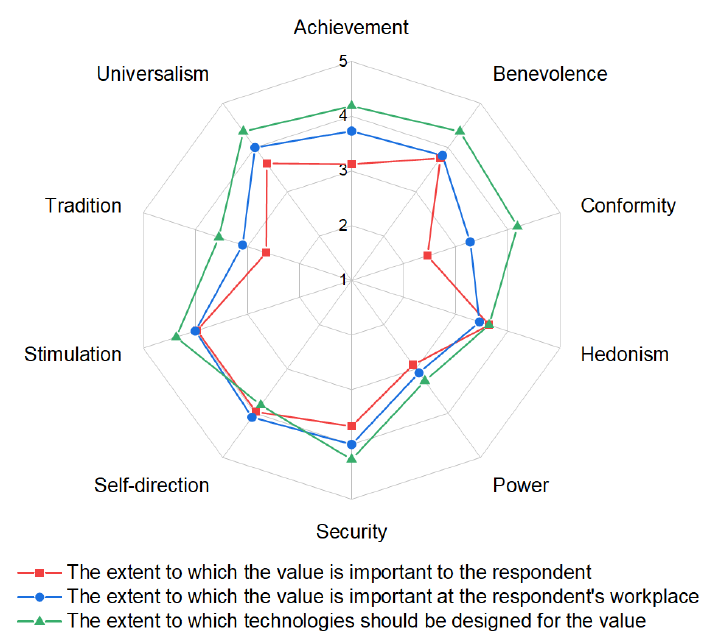
Figure 5. Perceived importance of the Schwartz’s ten values.